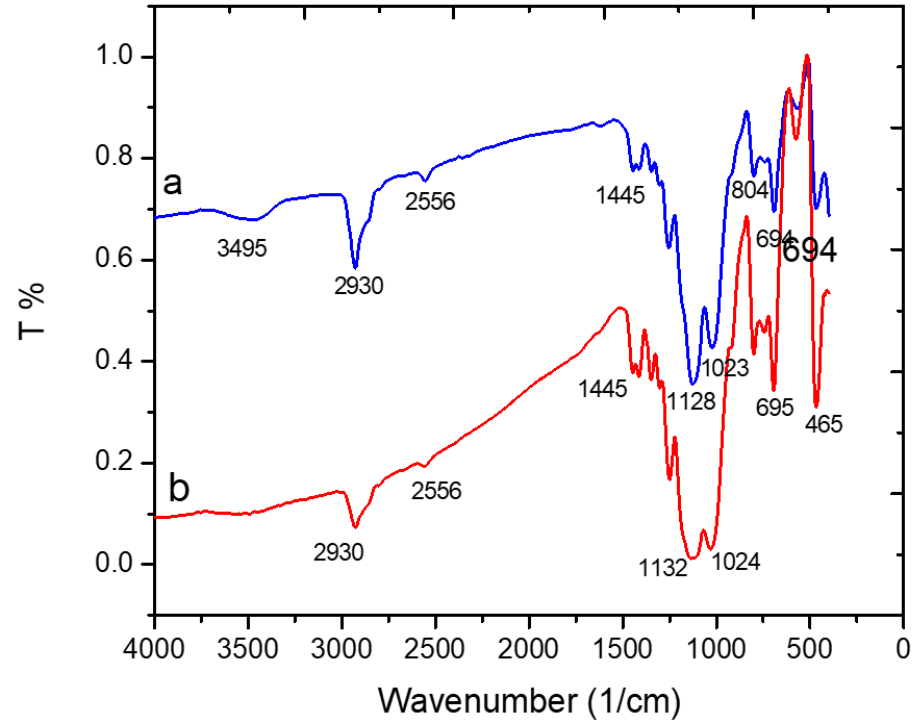
Figure 3. FTIR absorption spectrum of adsorbent (2), (a) before absorption and (b) after adsorption.